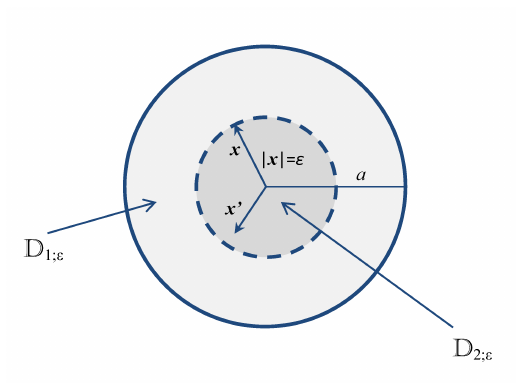
Figure 14: Integration over the domain D 2; (cid:15)